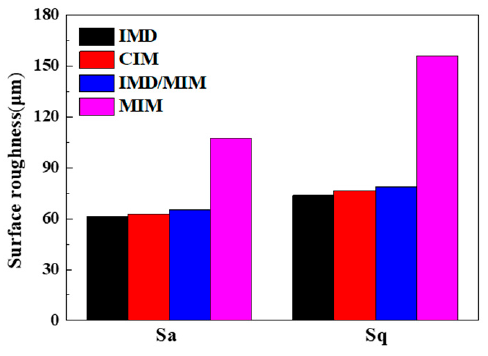
Figure 11. The comparison of the surface roughness indexes among the IMD, CIM, IMD / MIM and